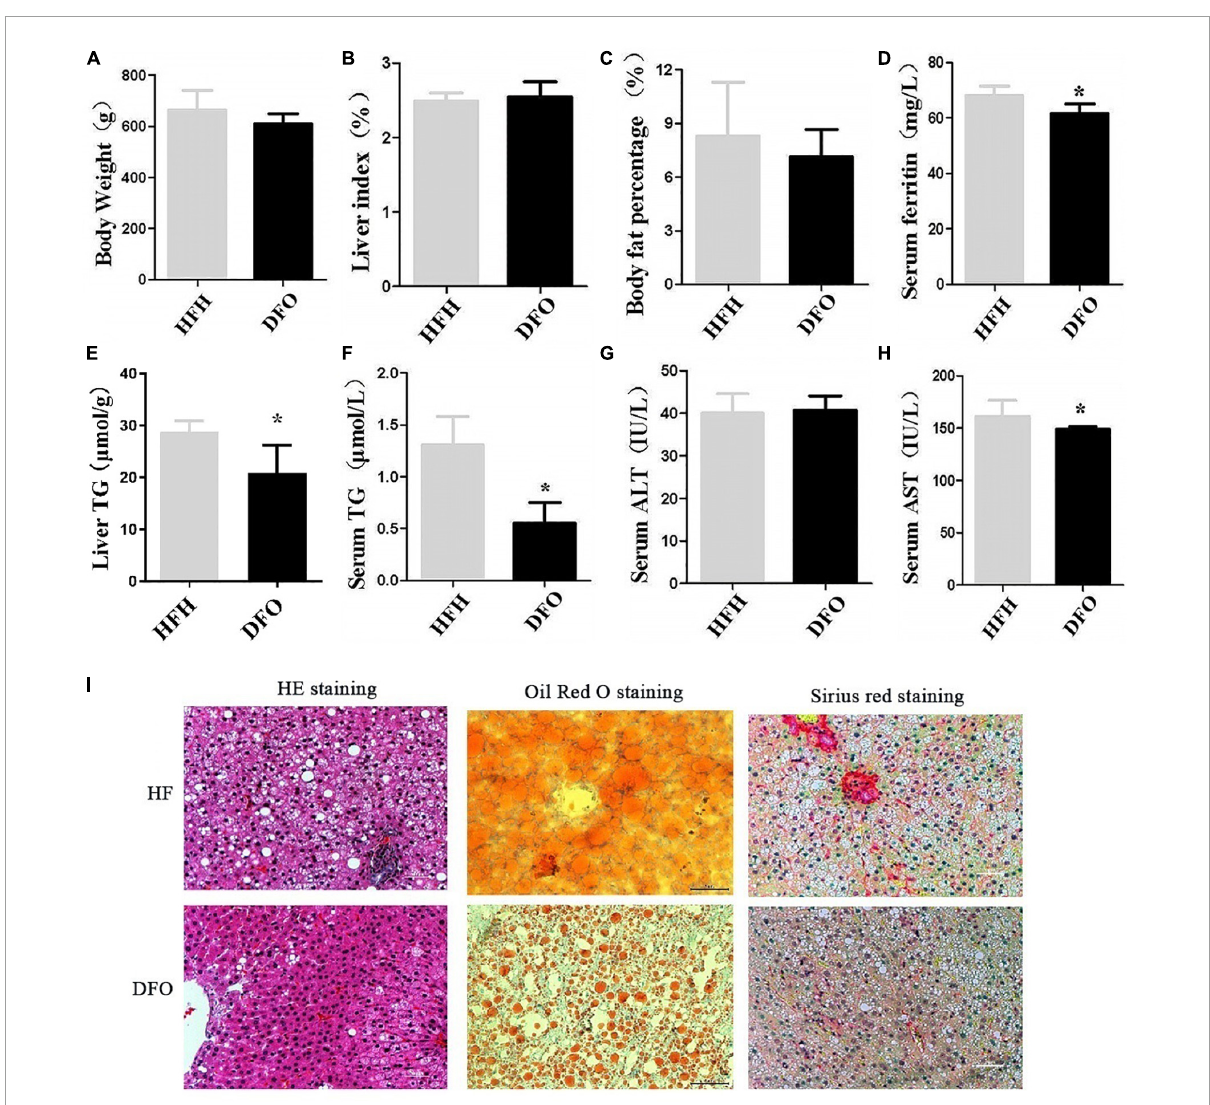
FIGURE3 DFO treatment improved lipid metabolism and liver injury induced by iron overload plus a HFD. (A) Body weight, (B) liver index, (C) body fat percentage, (D) serum ferritin, (E) liver TG, (F) serum TG, (G) ALT, and (H) AST levels in rats. (I) HE, Oil red O, and Sirius red staining at 20 weeks. * Compared with the HFH group, P < 0.05